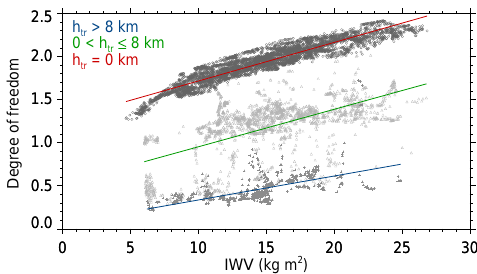
Figure 19. Degree of freedom as a function of IWV for the situa- tions introduced in Table 2. The lines indicate the according regres- sion